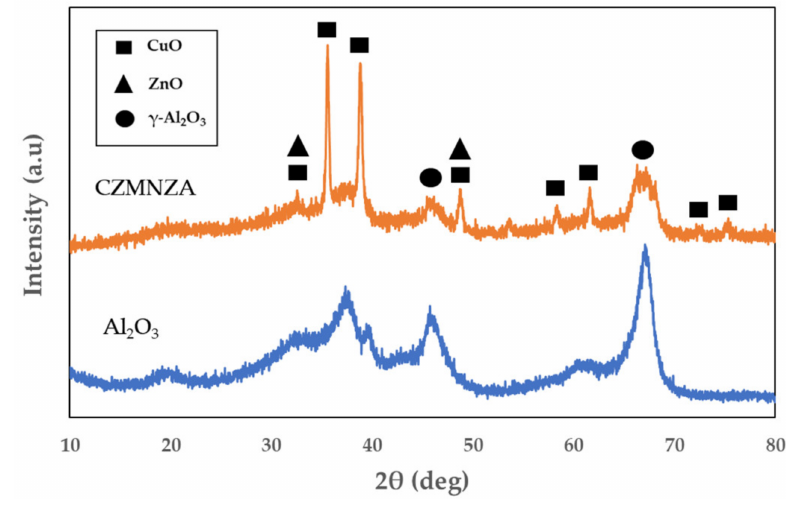
Figure 7. XRD patterns of Al 2 O 3 and CZMNZA.